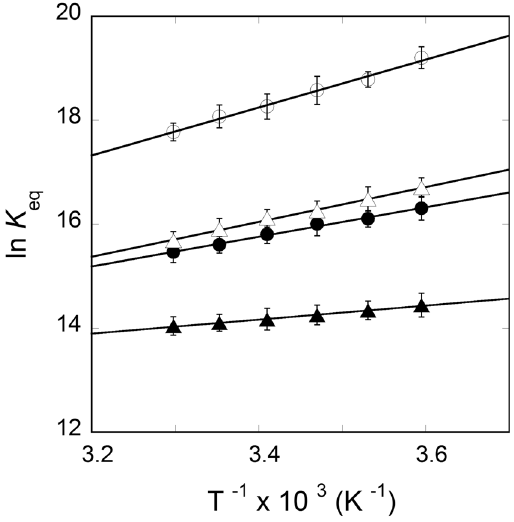
Figure 3. van’t Hoff plots for the interaction of FI IRE-RNA with IRP1 repressor protein in the absence and presence of Mn 2 + . The data are indicated as FRT IRE-RNA ( ‒○‒ ), FRT IRE-RNA + 50 µ M Mn 2 + ( ‒⦁‒ ), ACO2 IRE-RNA ( ‒∆‒ ) and ACO2 IRE-RNA + 50 µ M Mn 2 + ( ‒ ▲ ‒ ) with IRP1 protein. Enthalpy and Entropy were determined from the slope and intercept of the temperature dependent equilibrium binding measurements, respectively.